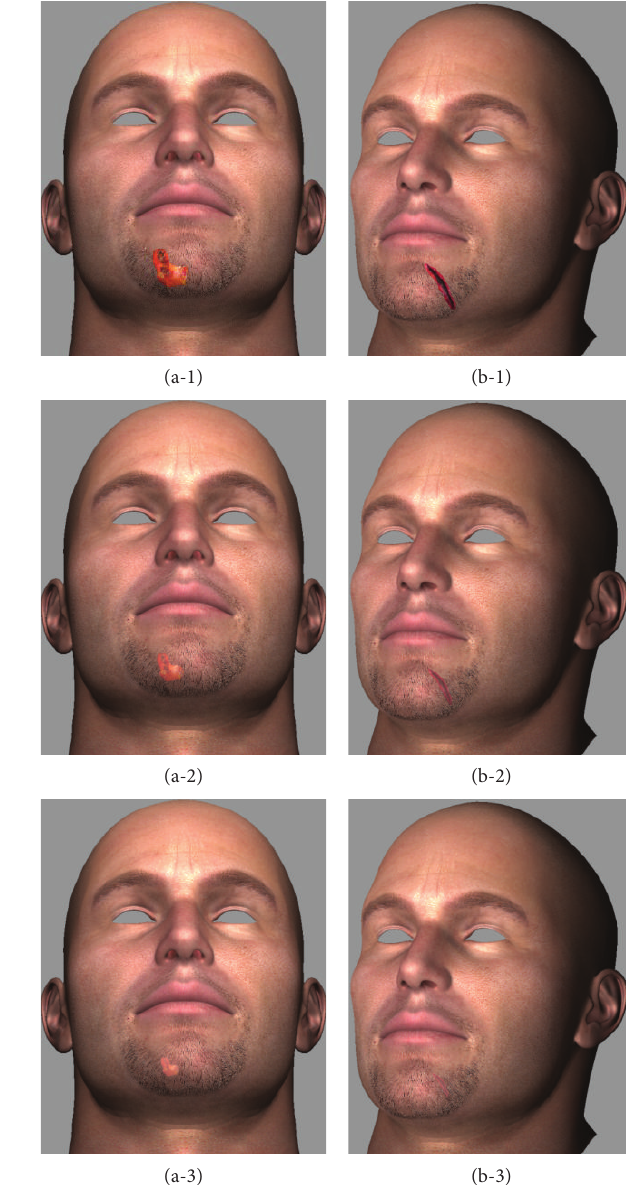
Figure 8: Rendering results showing the process of wound recovery synthesis.